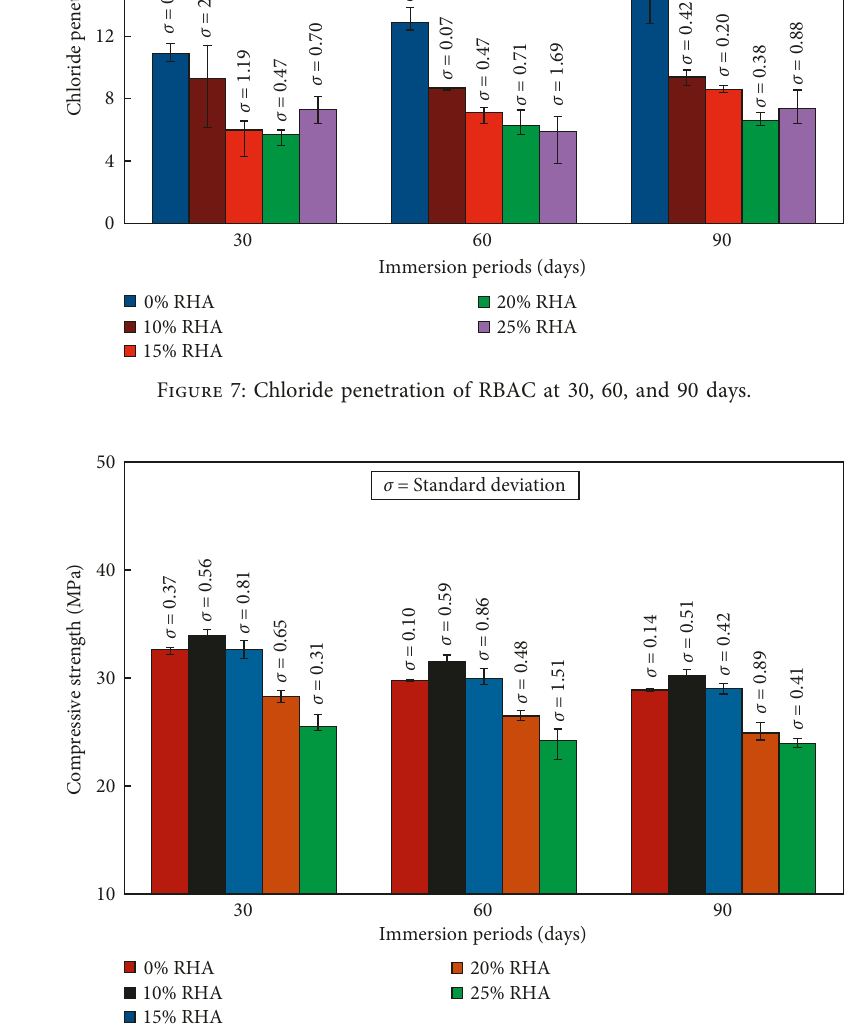
2 SO 4 solution for 30, 60, and 90 days.